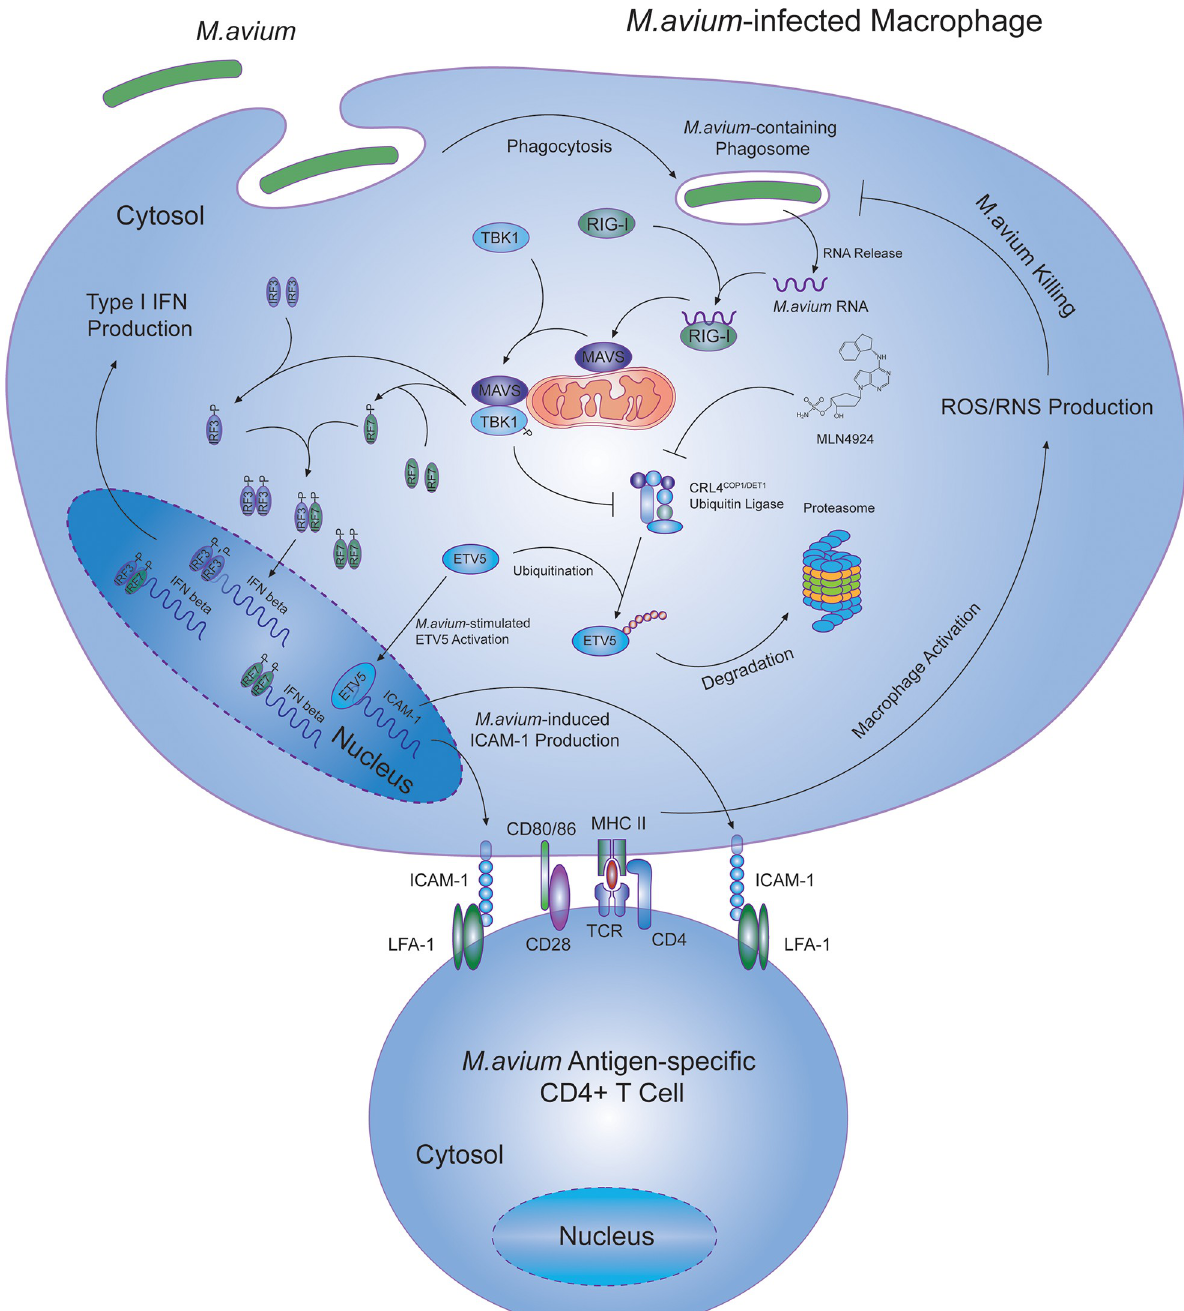
Fig 8. Host cytosolic RIG-I/MAVS/TBK1 RNA sensing pathway promotes antigen-specific CD4 + T cell-mediated mycobacterial killing in M . avium -infected host